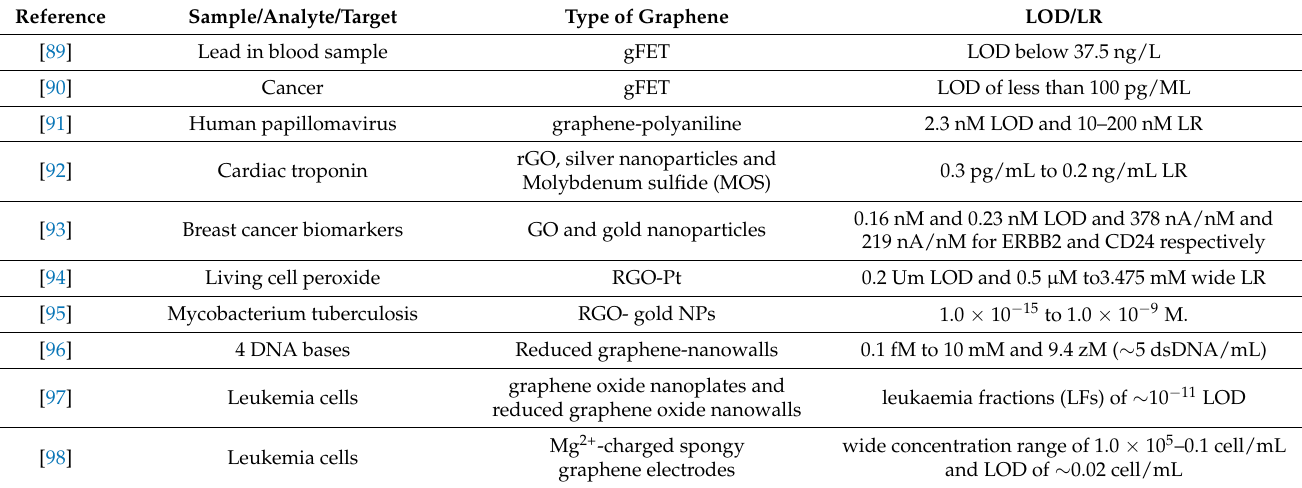
Table 4. Electrochemical nanomodified graphene-based